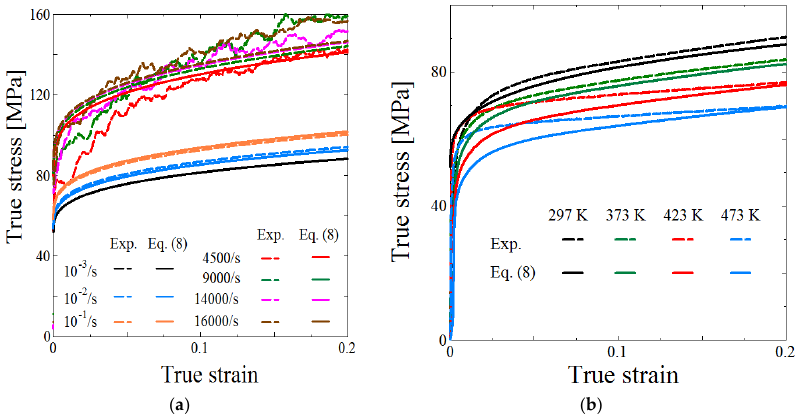
Figure 7. Stress-strain curves obtained by a quasi-static and impact test at various temperatures and directly calculated by Equation (8). ( a ) At various strain rates; ( b ) At various temperatures.